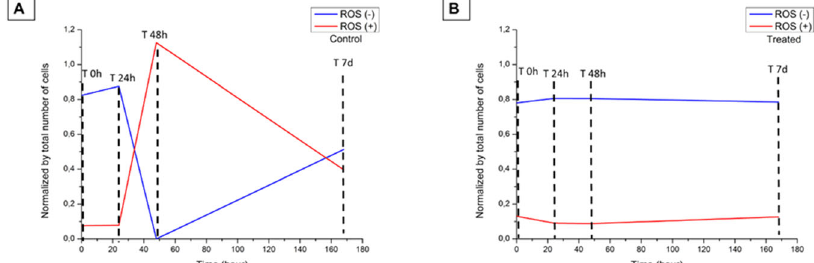
Fig. 8 Variability of the eBMMSCs ROS ( + ) and ( − ) during the respective moments: T 0 h, T 24 h, T 48 h and T 7d. A BMMSCs ROS ( + ) and ROS ( − ) detected in the control group. B eBMMSCs ROS ( + ) and ROS ( − ) detected in the treated